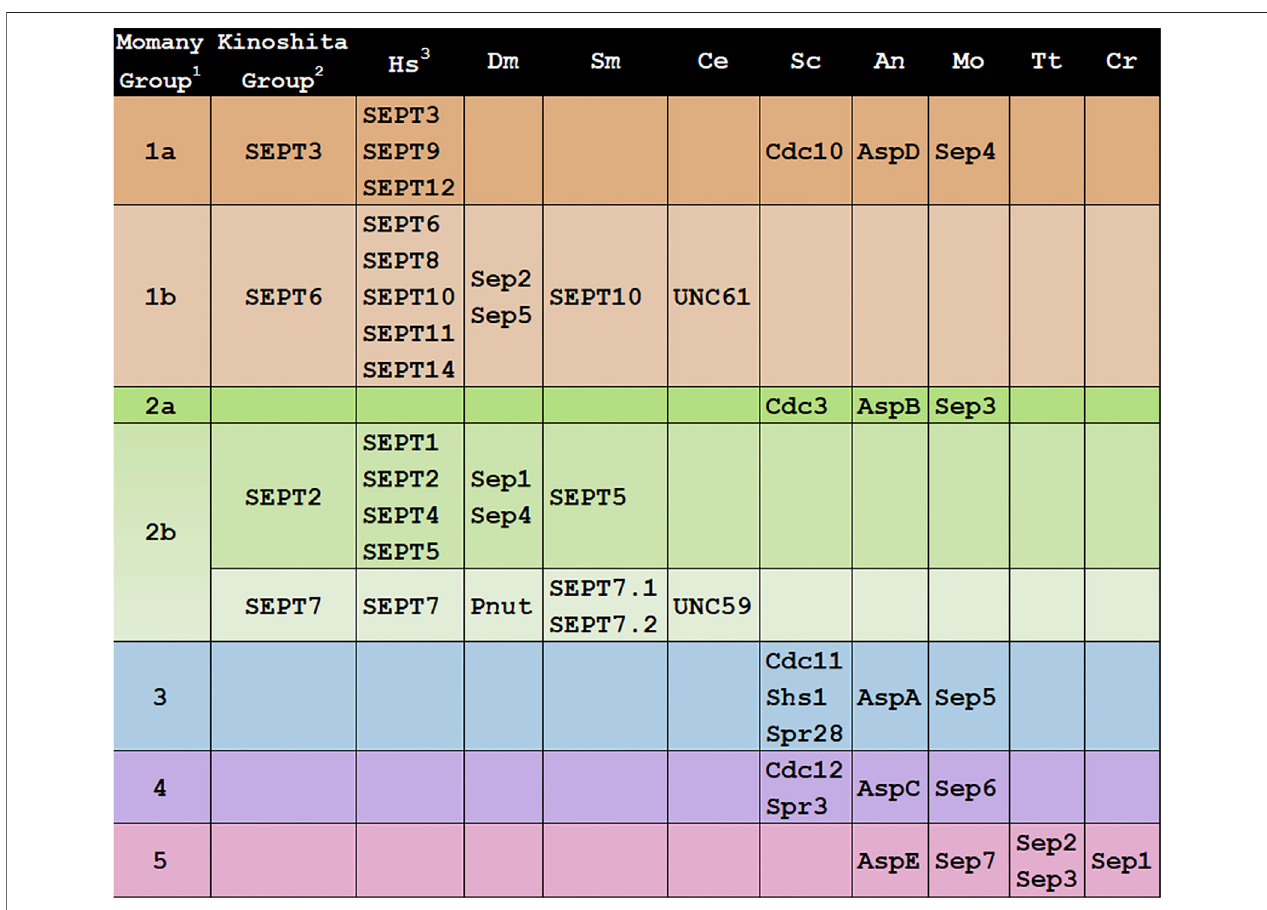
FIGURE1| GroupingsofseptinsacrossKingdoms.Septindesignationsforrepresentativemodelorganismsacrosskingdomsareshown.Proteinsequenceswere retrievedfromUniProt,WormBase,NCBI,orFungiDB. 1 All161then-availableseptinsequenceswereclassi fi edinto5groupsbytheMomanylab(Panetal.,2007). 2 All12 then-available human septins wereclassi fi edinto4homologous groups, members ofwhichwere proposed tosubstitute foreach other inapolymer ( “ Kinoshita rule ” )by the Kinoshita lab (Kinoshita 2003b). 3 Hs, Homo sapiens ; SEPT1( Q8WYJ6 ), SEPT2( Q15019 ), SEPT3( Q9UH03 ), SEPT4( Q6ZU15 ), SEPT5( Q99719 ), SEPT6( Q14141 ), SEPT7( Q16181 ), SEPT8( Q92599 ), SEPT9( Q9UHD8 ), SEPT10( Q9P0V9 ), SEPT11( Q9NVA2 ), SEPT12( Q8IYM1 ), SEPT14( Q6ZU15 ); Dm, Drosophila melanogaster ; Sep1( P42207 ), Sep2( P54359 ), Sep4( Q0KHR7 ), Sep5( Q7KLG8 ), Pnut( P40797 ); Sm, Schistosoma mansoni ; SEPT5( KC916723 ), SEPT7.1( KC916724 ), SEPT7.2( KC916725 ), SEPT10( KC916726 ); Ce, Caenorhabditis elegans ; UNC-59 ( CE20165 ), UNC-61( CE47829 ); Sc, Saccharomyces cerevisiae ; Cdc3( YLR314C ), Cdc10( YCR002C ), Cdc11( YJR076C ), Cdc12( YHR107C ), Shs1( YDL225W ), Spr3( YGR059W ), Spr28( YDR218C ); An, Aspergillus nidulans : AspA( AN4667